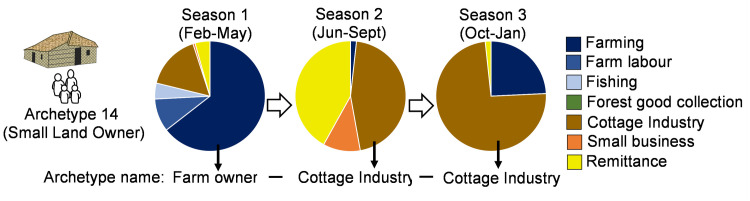
An example of the archetypal household classification.The pie charts shows a household’s seasonal income distribution. The archetype grouping and the name of the archetype is based on the income that dominates in each season. For example, this small land owner archetype 14 is described as Farm Owner–Cottage Industry–Cottage Industry.